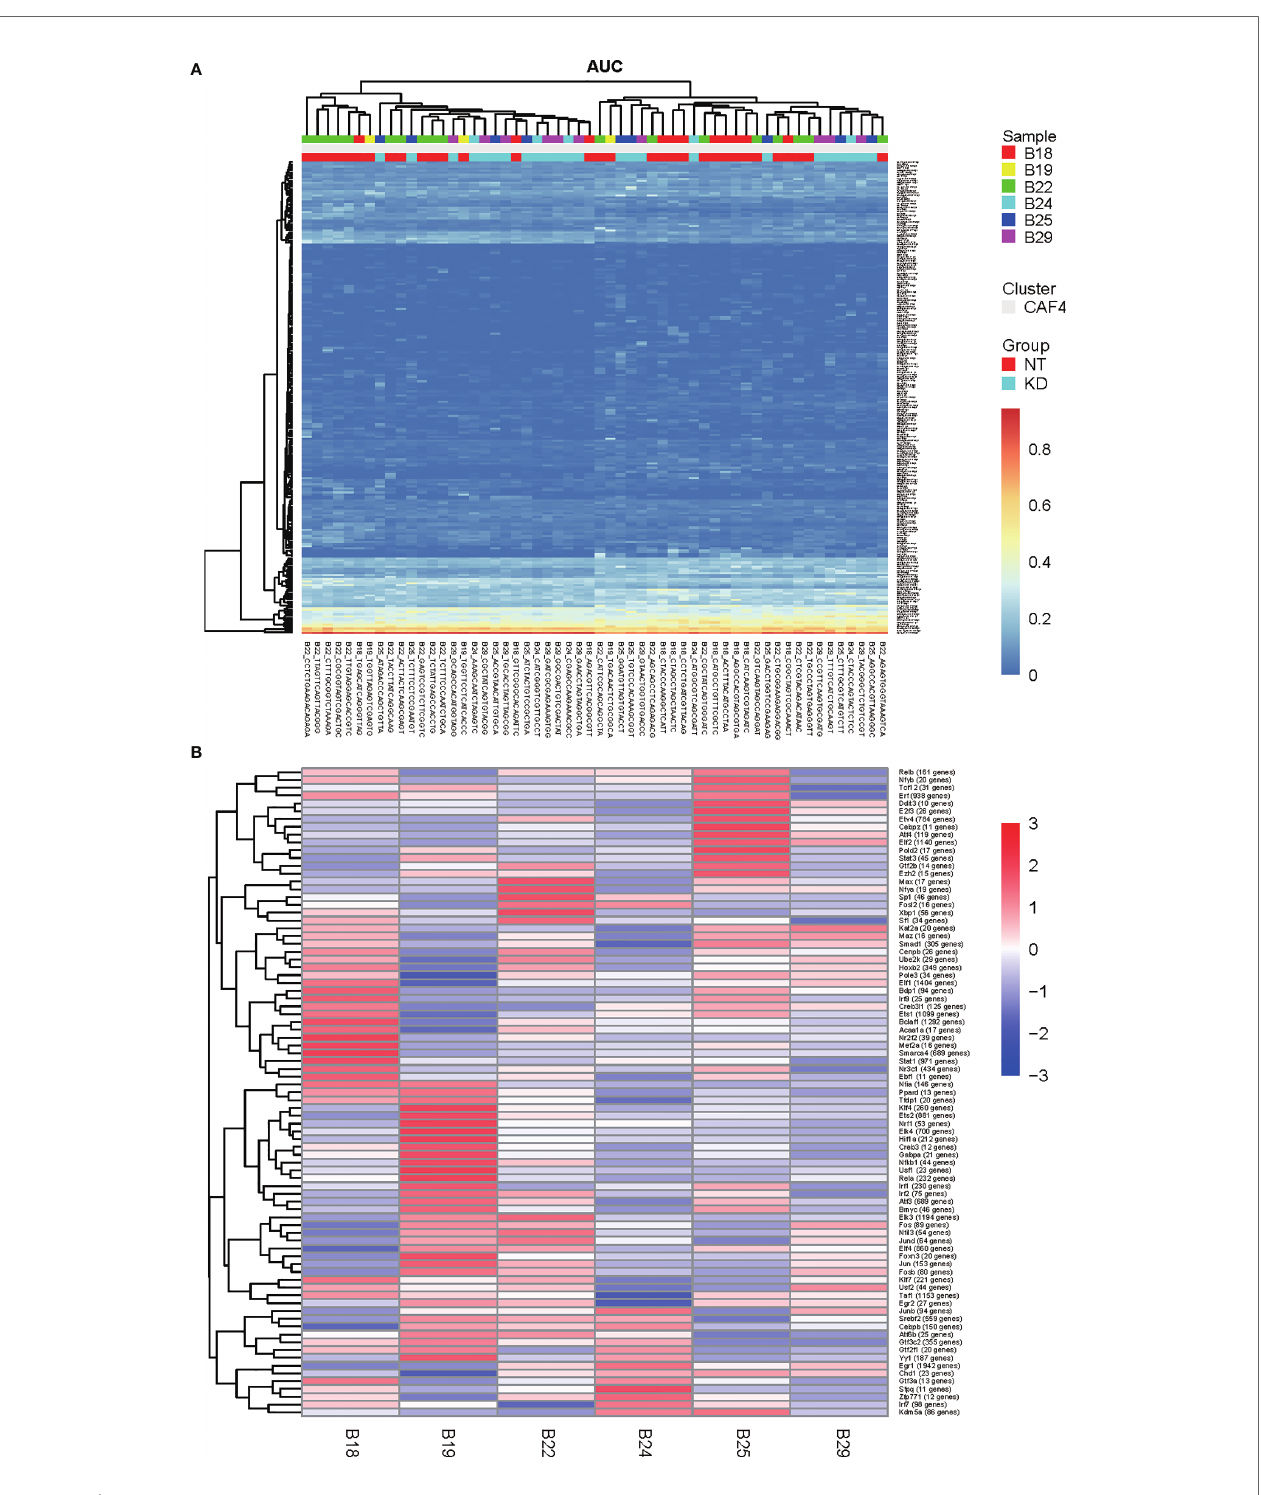
FIGURE 4 | SCENIC analysis of CAF in mouse CT26 tumor (A, B) . Single cell regulatory network inference and clustering (SCENIC) analysis. By using SCENIC to predict transcription factors and corresponding target genes, a transcription factor regulatory network module was constructed. By calculating the area under the curve (AUC), the higher the AUC value, the stronger the regulatory activity of transcription factors to activate target gene expression (A) SCENIC analysis to assess transcription factors which underlie differences in expression of CT26 tumor cell between NT and Bcl9 KD tumor cells. (B) Average activity of regulons in different cell